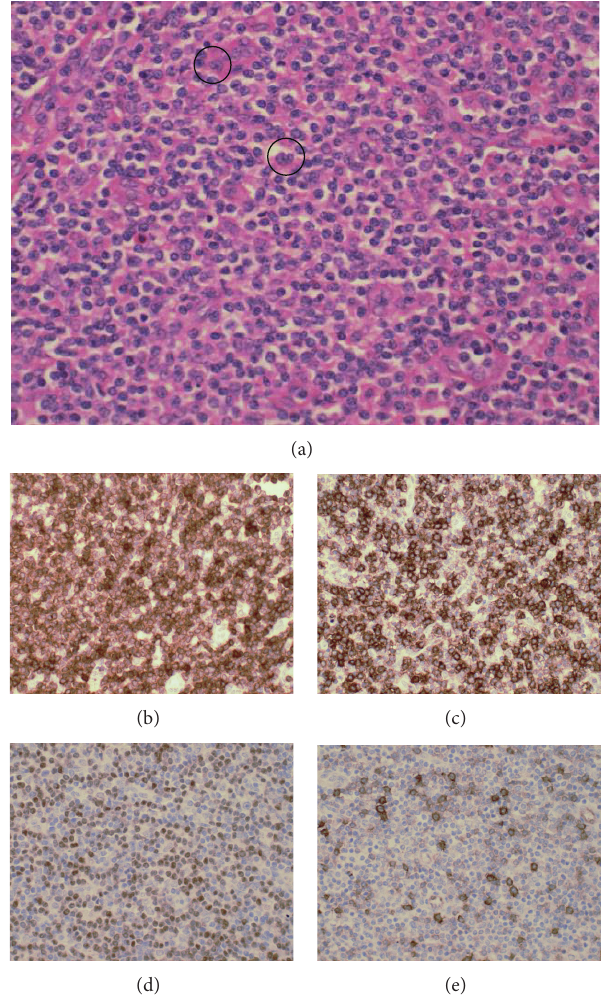
Figure 3: Left axillary lymph node biopsy (original magnification × 400). Haematoxylin and eosin: (a) infiltration of the node by predominantly small lymphoid cells and occasional “hallmark” cells (circled in black), CD3 immunostain positive (b), CD8 immunostain positive (c), ALK immunostain-positive nuclear staining (d), and CD30 immunostain scattered positivity in large cells (e).